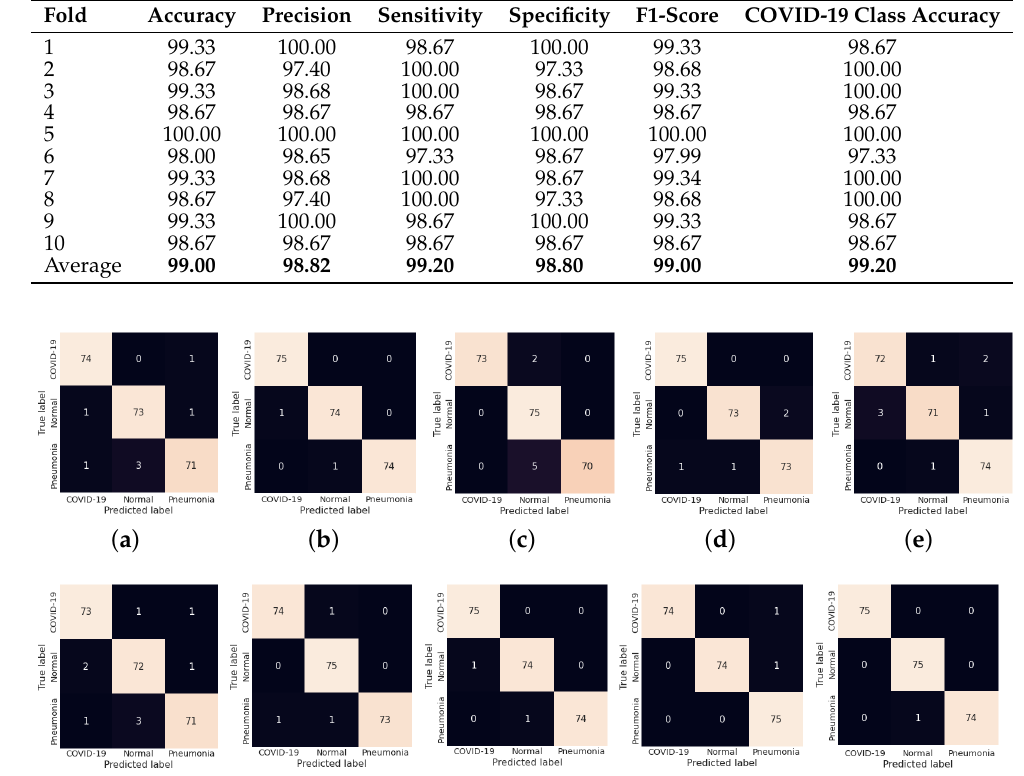
Table 6. Fold-wise binary classification performance (in %) on Dataset-1.